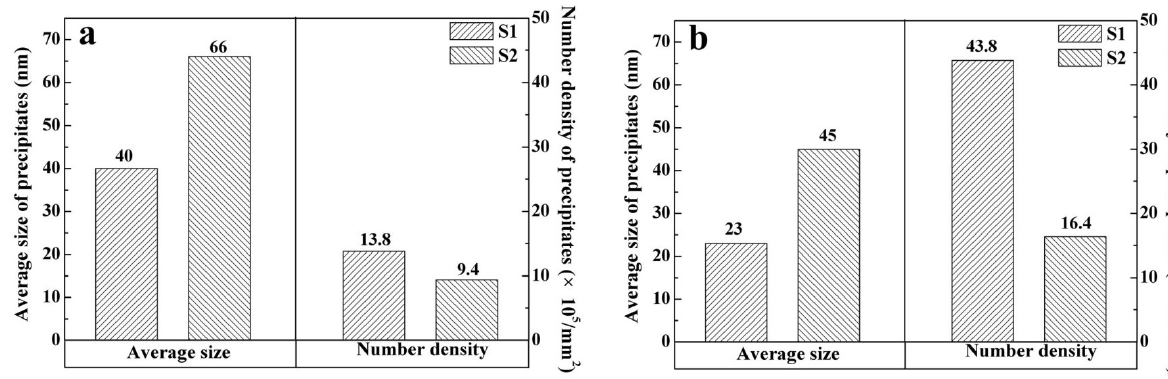
Figure 3: Size and number density of precipitates in (a) hot-rolled sheet, (b) normalized